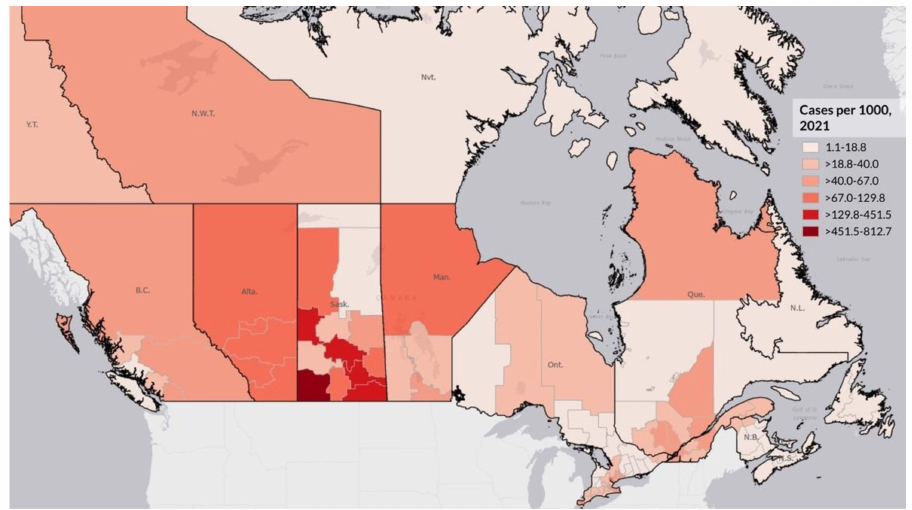
Figure 3. Logged COVID-19 Cases in 2021 per 1000 by Canadian Health